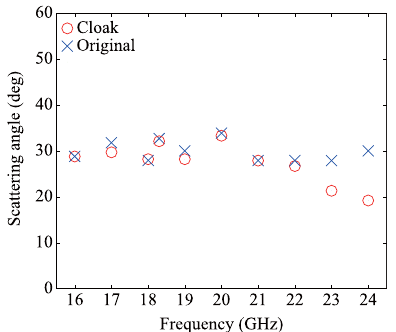
Fig. 7. Frequency dependence of the specular scattering angles obtained from the BRCSs for u inc =30 (cid:4) . The red circles represent the scattering angles for the cloak and the blue cross marks represent those for the